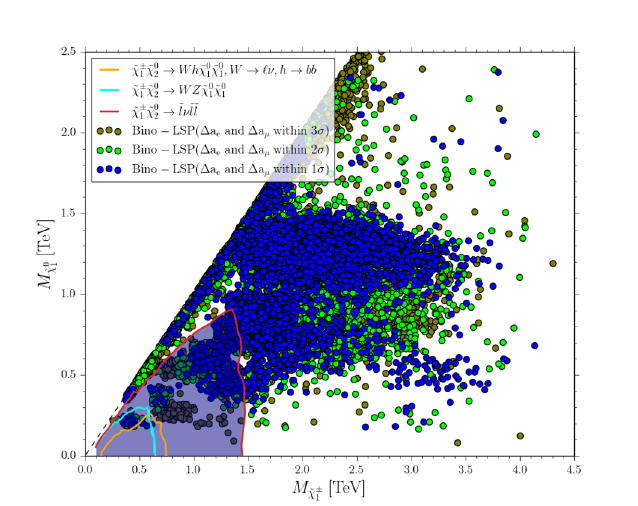
Figure 5 . The favored parameter space with bino dominated LSP along with the LHC constraints derived from direct